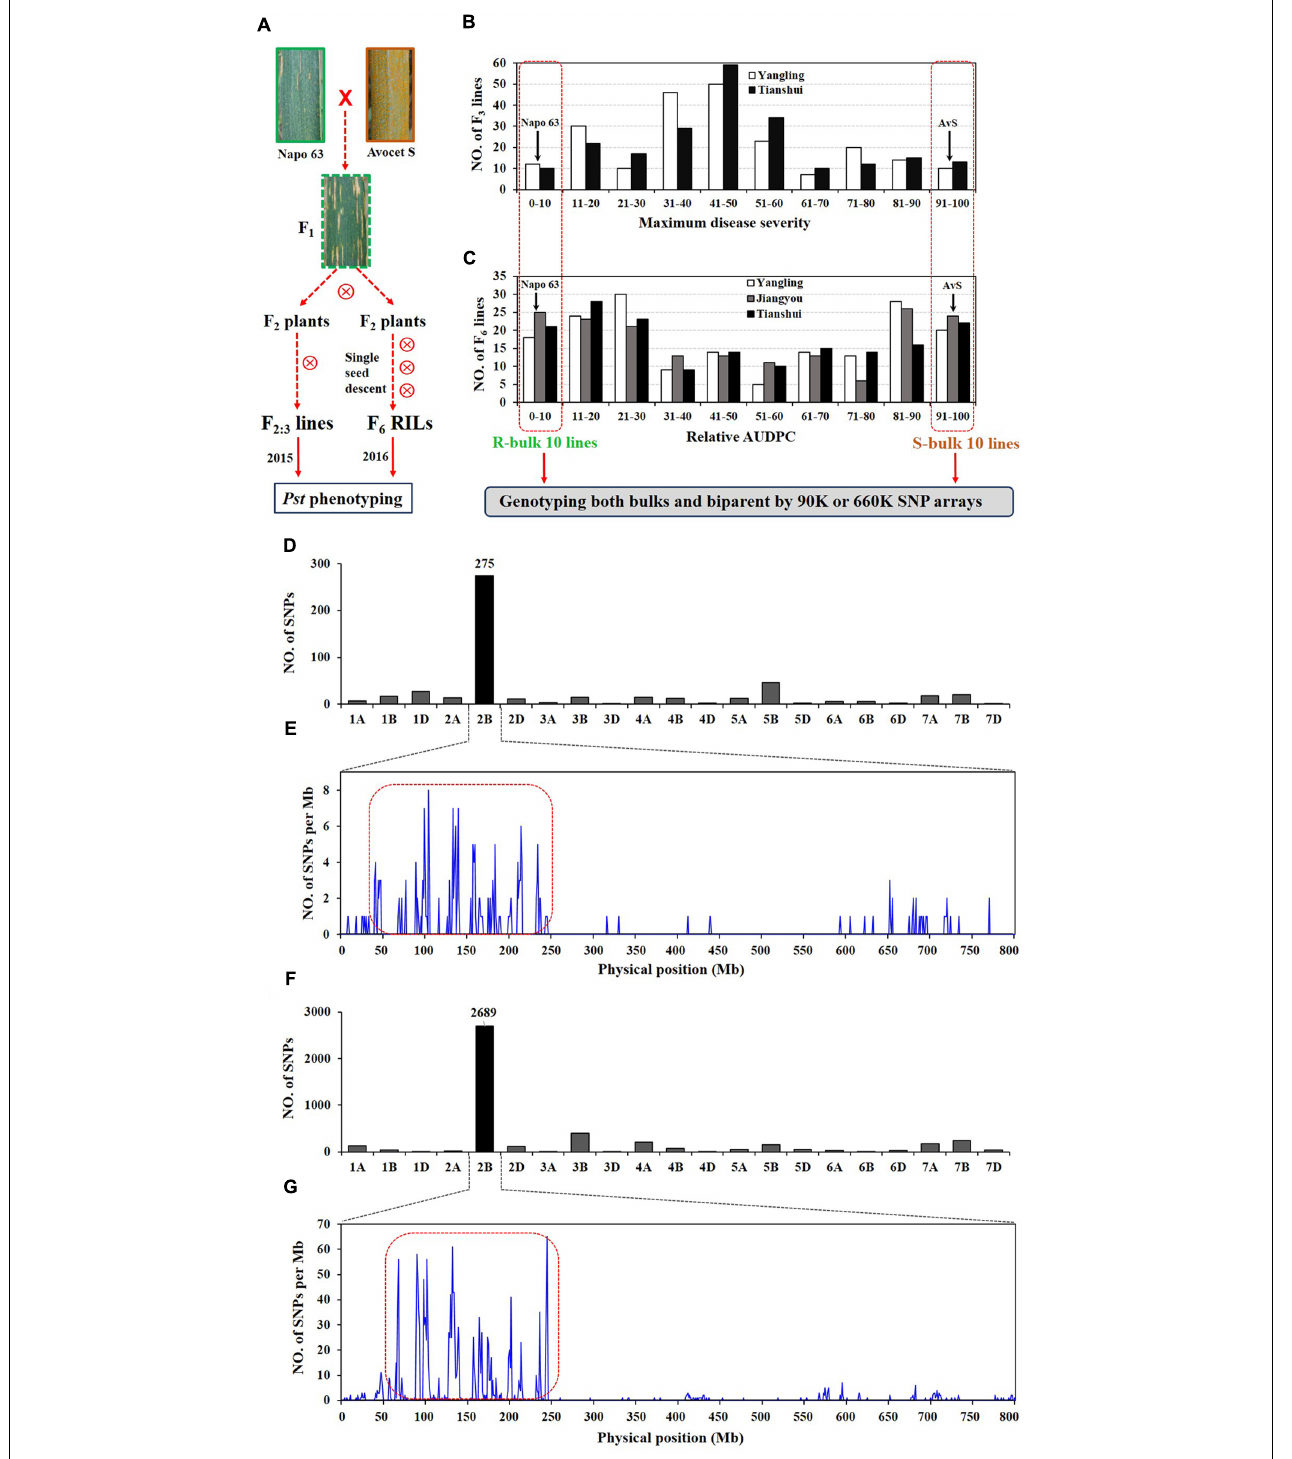
FIGURE 1 | Overview of analyses. F 2 : 3 lines and F 5 : 6 recombinant inbred lines (RILs) were derived from the cross AvS × Napo 63. (A) Phenotypes of AvS, Napo 63 and their progenies across all environments and data collected at heading-flowering stage. (B) Frequency distribution of maximum disease severity (MDS) for 221 F 2 : 3 lines grown at Yangling and Tianshui in 2015. (C) Frequency distribution of relative area under the disease progress curve (rAUDPC) for 175 F 6 RILs grown at at Yangling, Jiangyou and Tianshui in 2016. Black arrows indicate the parental line means. Distributions of the polymorphic SNPs in each chromosome by 90K (D) and 660K (F) SNP arrays and positions of SNPs in chromosome 2B (E,G) . Selected SNPs (in the red dotted boxes) were analyzed in KASP assays.